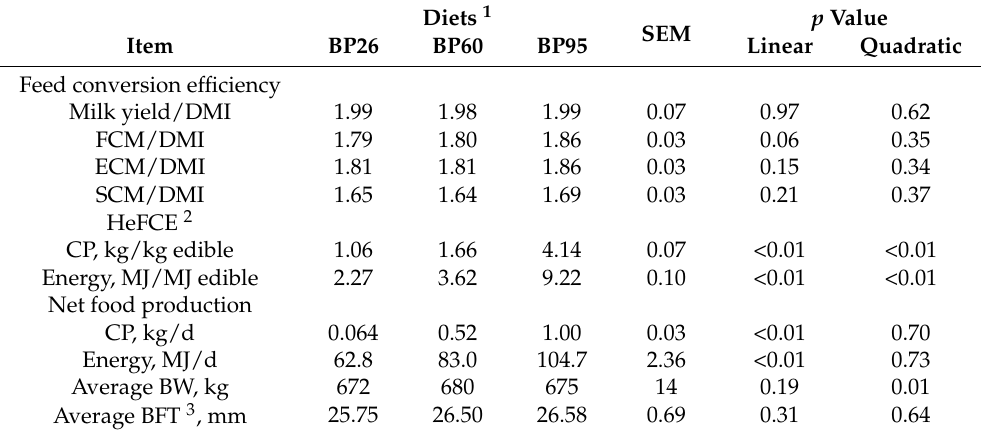
Table 8. Effect of replacing human-edible feed ingredients with byproducts on feed conversion efficiency, human-edible efficiency and net food